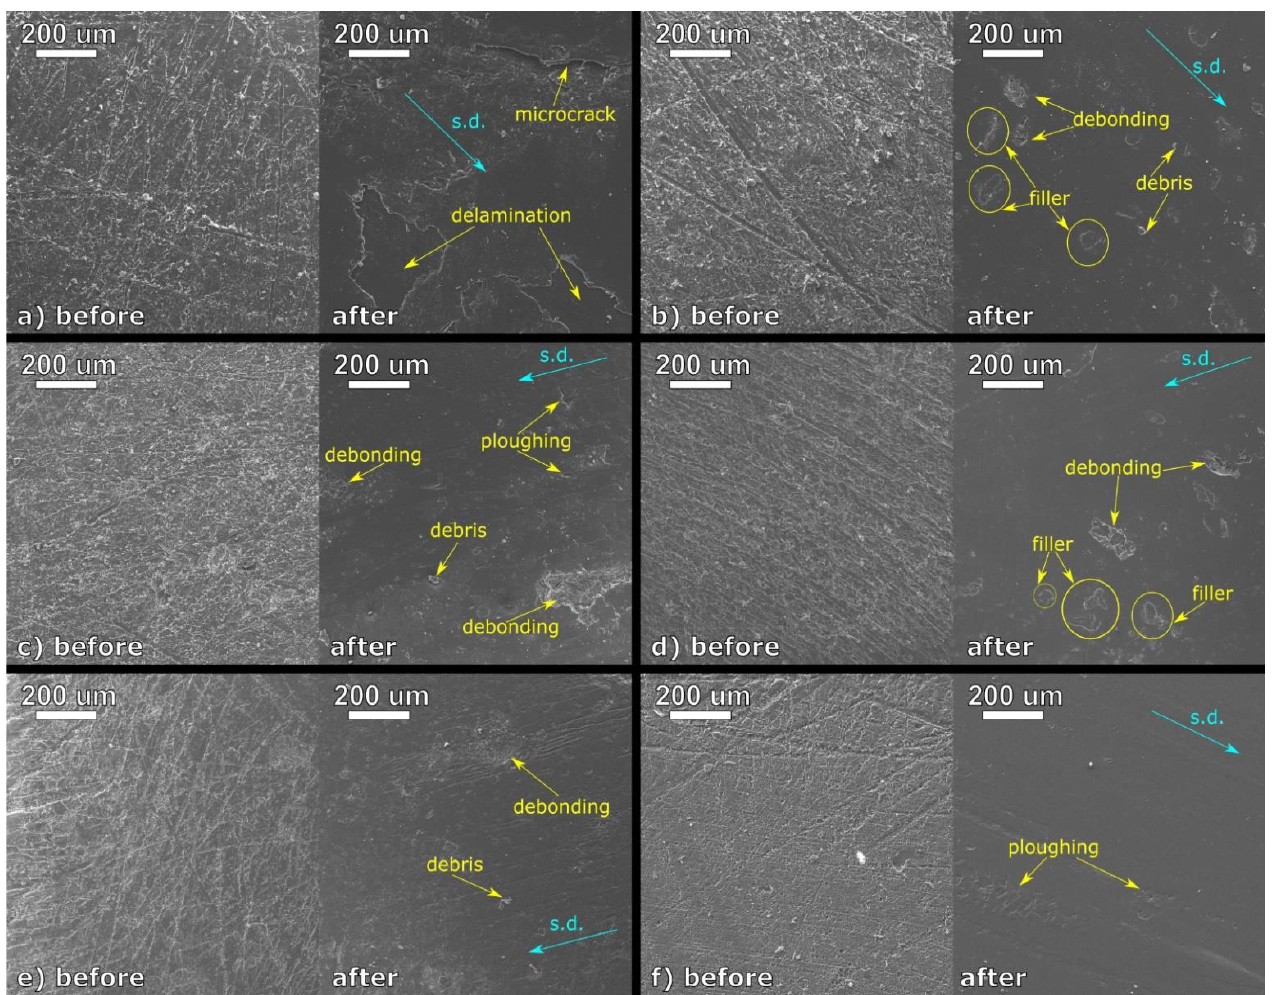
Figure 7. SEM images of the surfaces of the samples before and after the frictional test: PLA ( a ), PLA-LC0.9 ( b ), PLA-LC4.6 ( c ), PLA-LC17.7 ( d ), PLA-LC30.4 ( e ), and PLA-LC39.8 ( f ). S.d. indicates the sliding direction. Table 2. Mass loss, density, and the specific wear rate of the worn